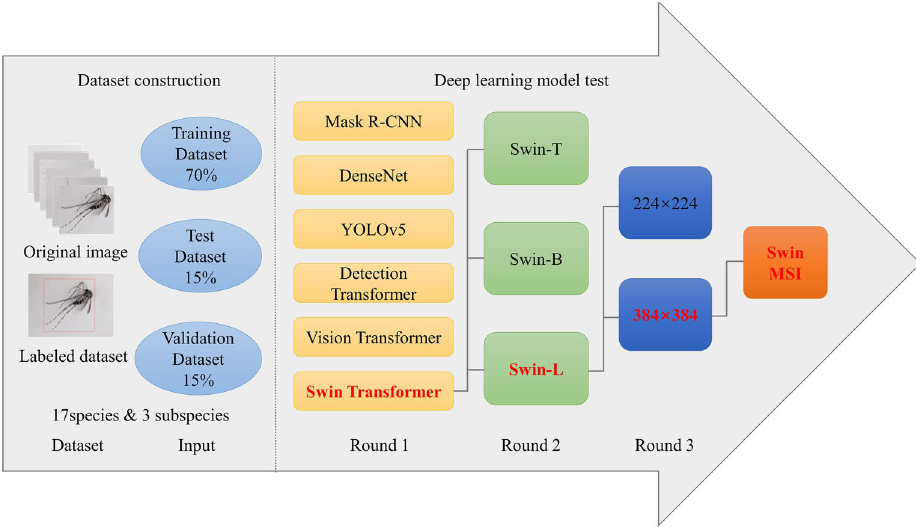
Figure 3. Flowchart of testing deep learning model for intelligent identification of mosquito species.